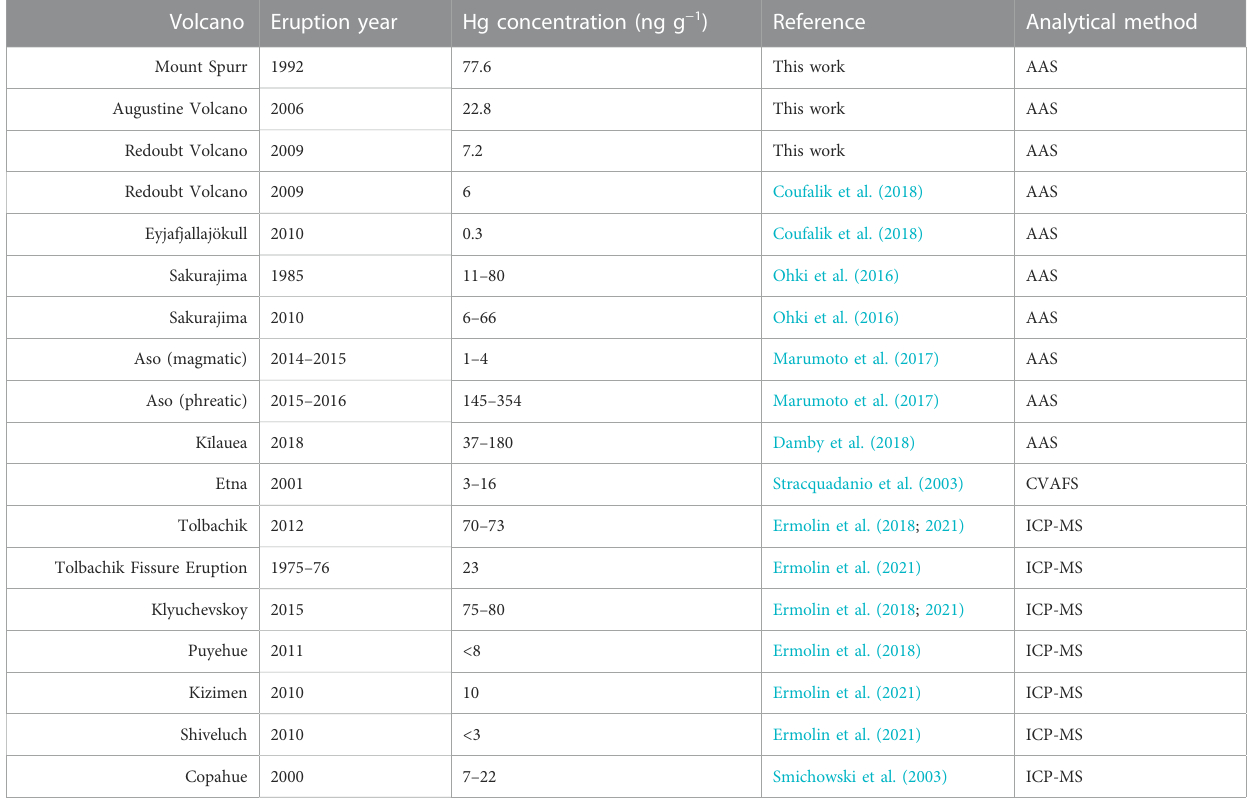
TABLE 3 Literature values of PBM in volcanic